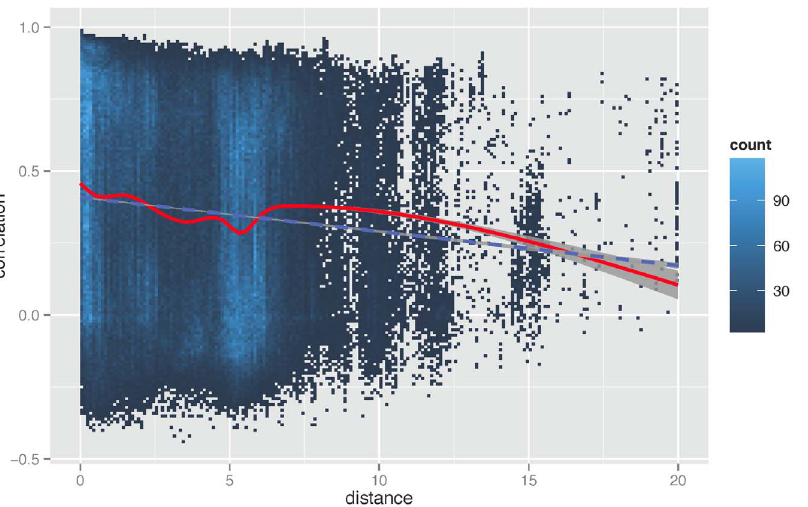
Figure 7. Distance affects pedestrian flow correlations in a city-scale. Correlation in pedestrian flows as affected by distance (in meters) between two locations. Approximately 300000 points contained in this figure, and contain all locations in our dataset. Blue dashed line indicates the regression between the two variables, while the red solid line shows the LOWESS smoother that uses locally-weighted polynomial regression. Both contain a confidence interval at p=0.99. The results confirm a negative relationship between physical distance and pedestrian flow correlation amongst pairwise locations. The scatterplot contains some clustered sets of points at distance=10, 12 and 15 kilometres, highlighting spatial clusters of WiFi access points and the polycentric nature of the